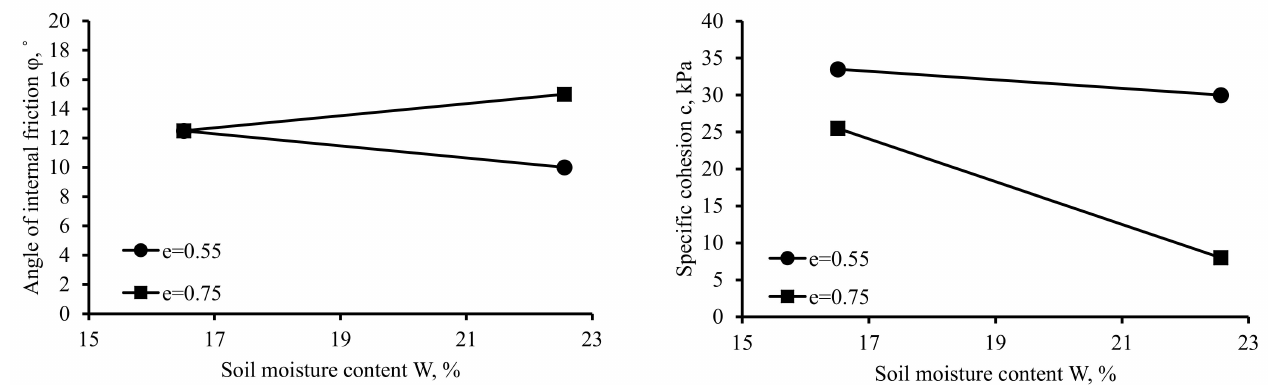
Figure 3. Effect of the interaction of factors X 1 X 2 on the strength characteristics of soil.